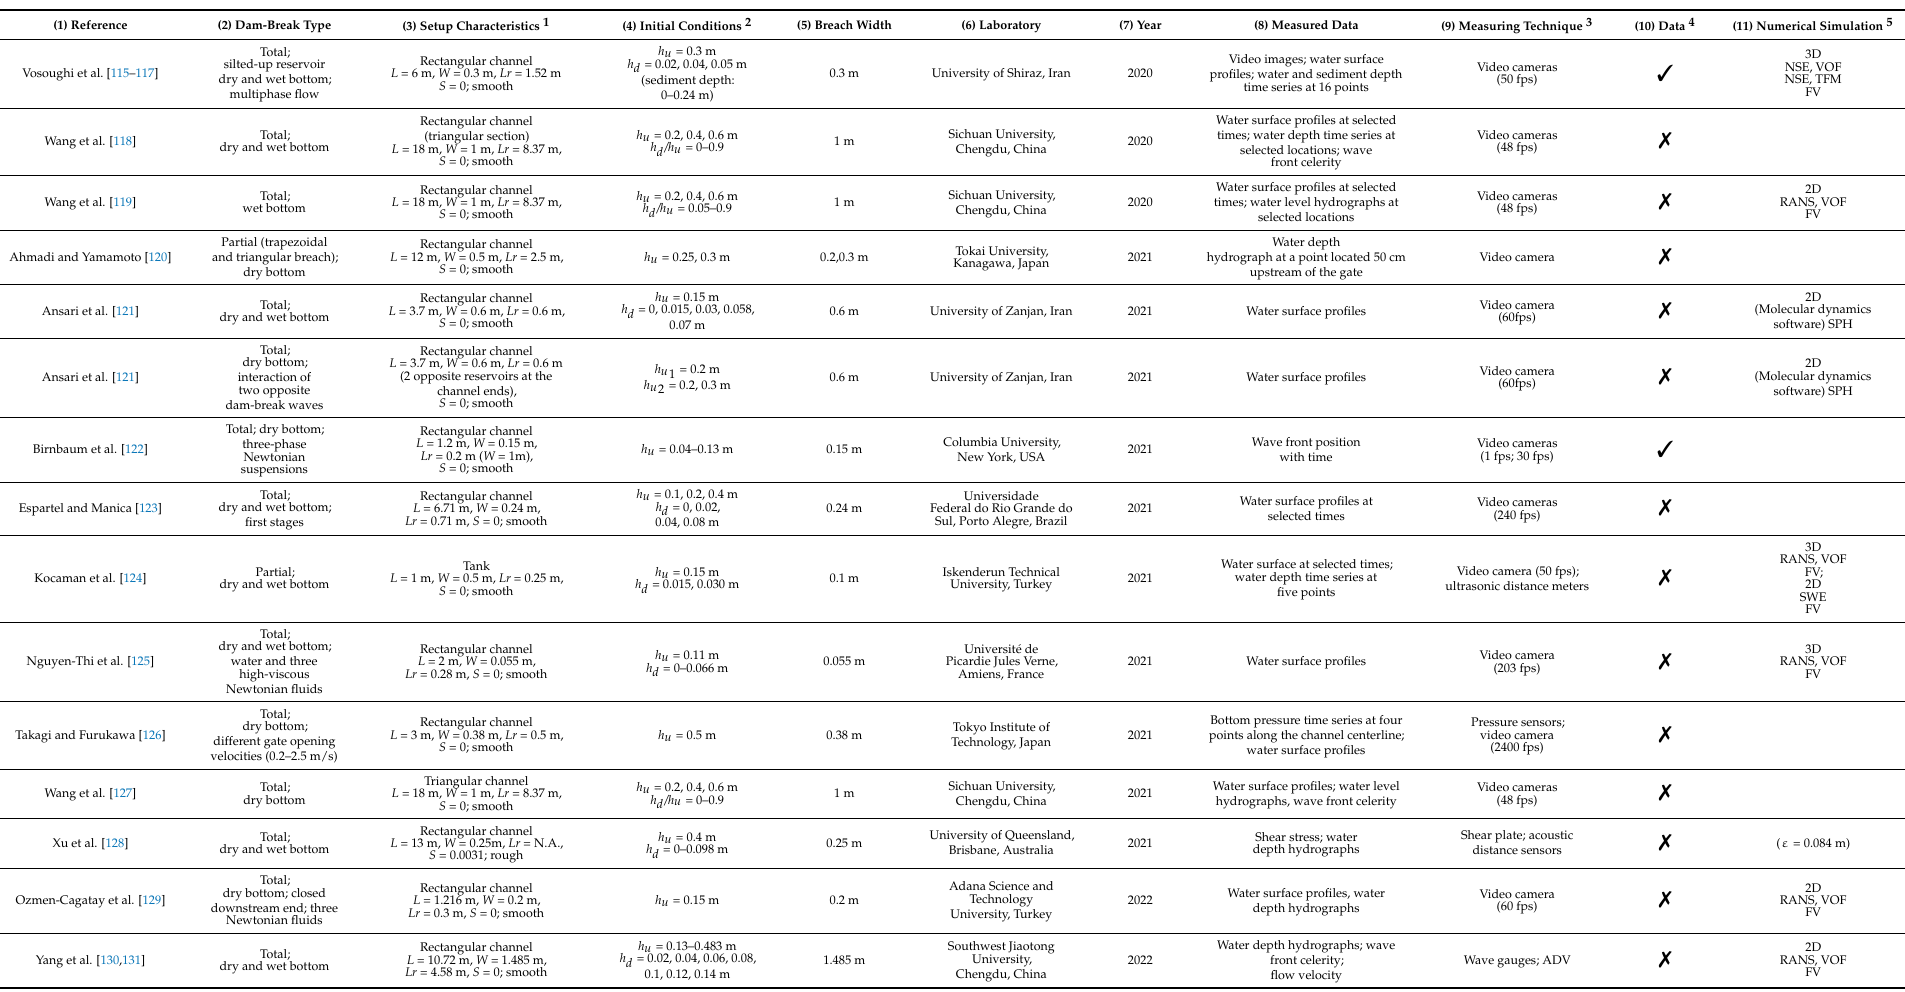
Table 1. Basic experimental investigations of fundamental dam-break wave physical characteristics.